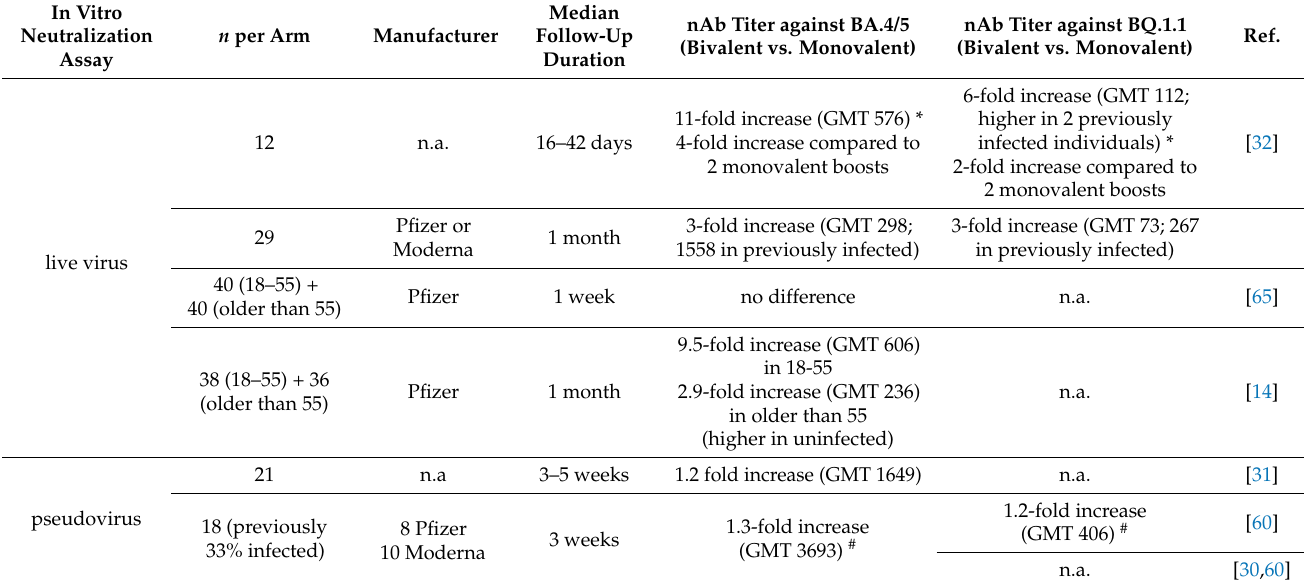
Table 1. Summary of in vitro neutralization data of sera from individuals comparing geometric mean titers (GMT) after Omicron-updated vs. wild-type mRNA vaccines as fourth doses after three previous doses of mRNA vaccines (* after 2 previous doses of mRNA vaccines; # range 2–4 previous